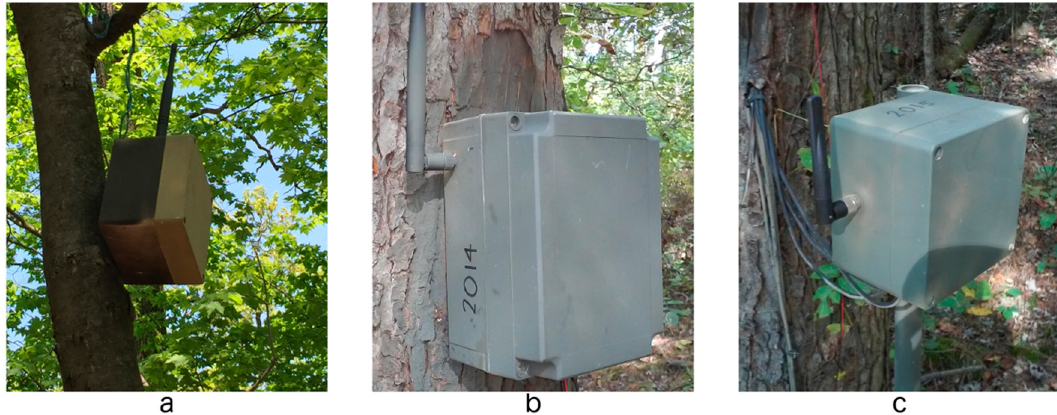
Figure 3. Examples of node types and their enclosures in the ASWP network, including ( a ) relay nodes hanging from a tree branch; ( b ) sap flow node mounted to the side of a tree; and ( c ) soil sensor node mounted to a PVC pipe.